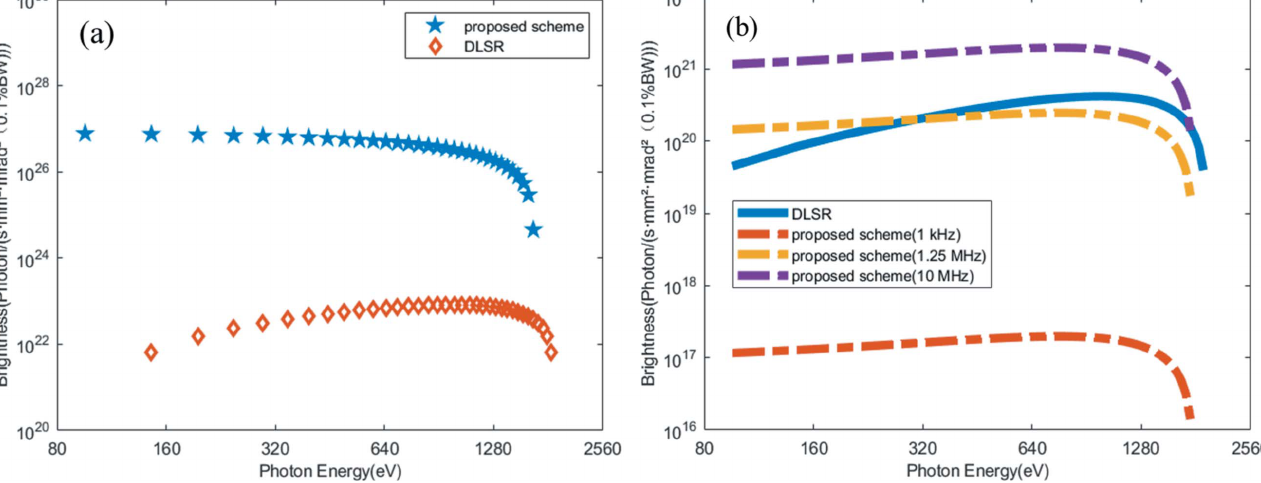
Figure 8 ( a ) Comparison of the peak brightness between the proposed scheme and diffraction-limited storage ring. ( b ) Comparison of the average brightness for the diffraction-limited storage ring (100 MHz) and the proposed scheme (1 kHz, 1.25 MHz, 10 MHz) without considering the limitation of the laser repetition